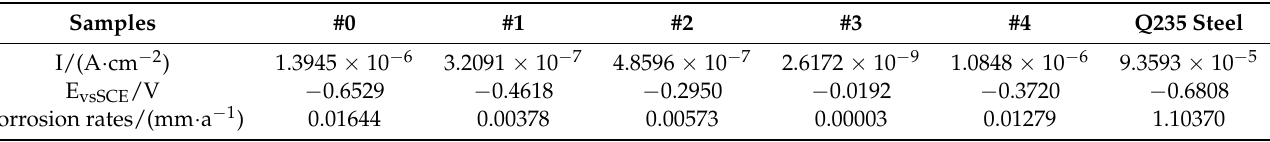
Figure 7. Potentiodynamic polarization curves of different WPU SCCs immersed in NaCl solution. Table 5. Fitted parameters of potentiodynamic polarization curves for the composites with different modified fillers.